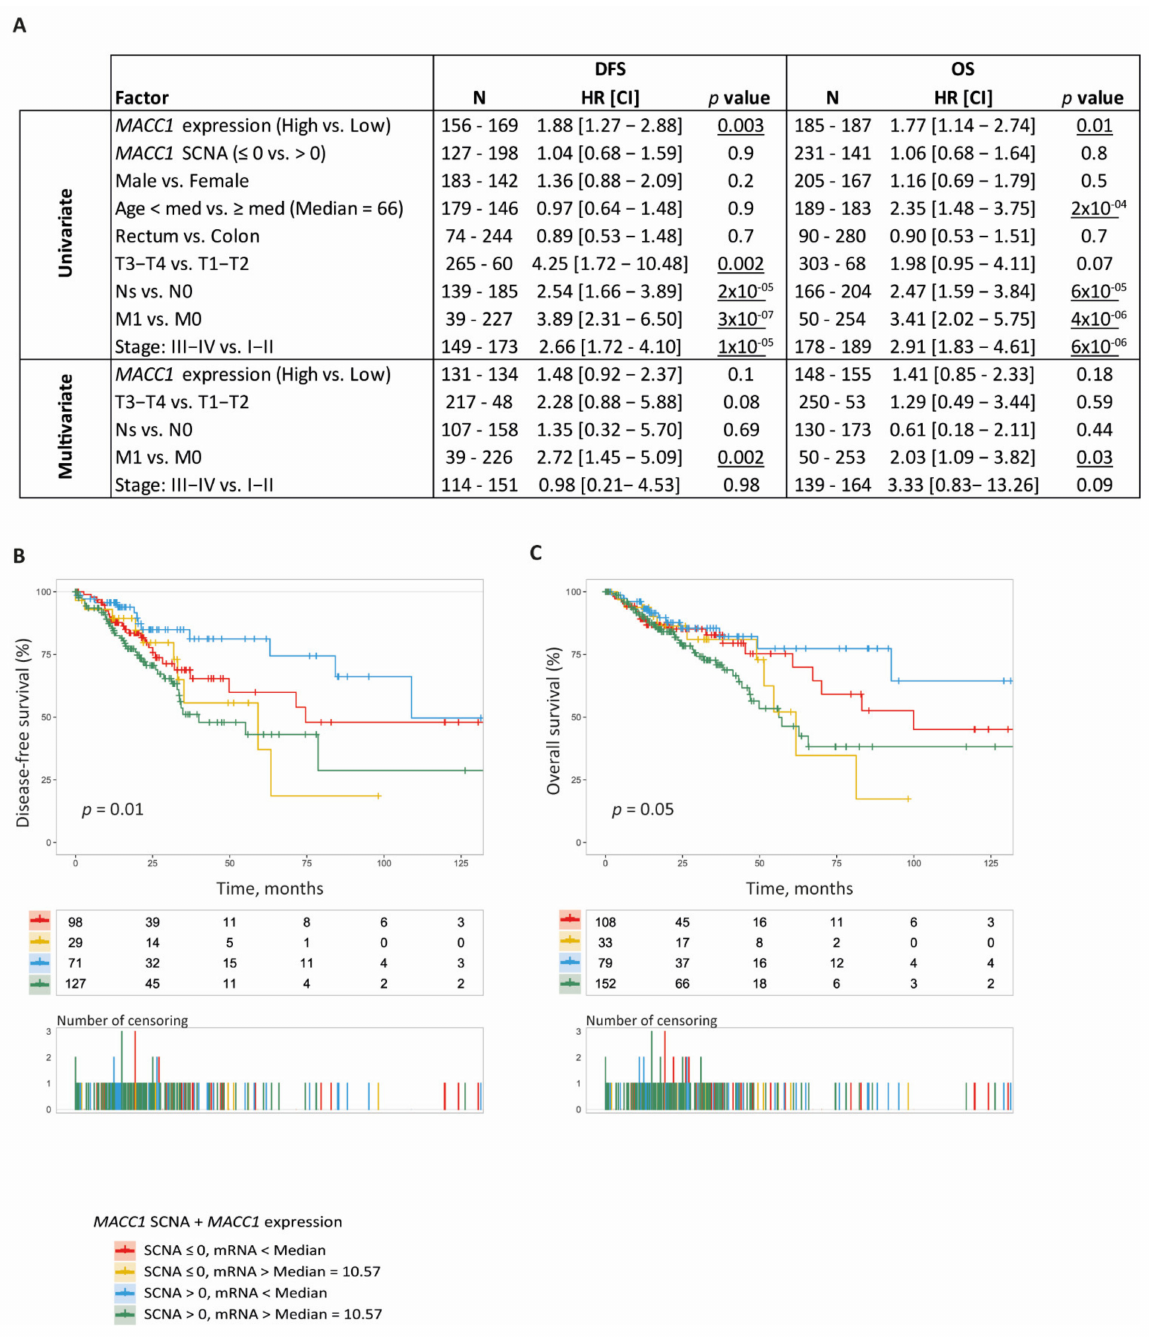
Figure 4. MACC1 SCNA and expression and CRC patient DFS and OS. ( A ), Univariate and mul- tivariate Cox analysis (DFS and OS) in COAD-READ TCGA patients (N = 218). HR: Hazard ratio; CI: Confidence interval. N represents the number of cases in each group. Wald test was used to identify the risk factors with patient DFS and OS. Significance setup at p < 0.05. ( B , C ), Combined Kaplan-Meier analysis of MACC1 status (SCNA and mRNA). ( B ), DFS according to the MACC1 status, ( C ), OS according to the MACC1